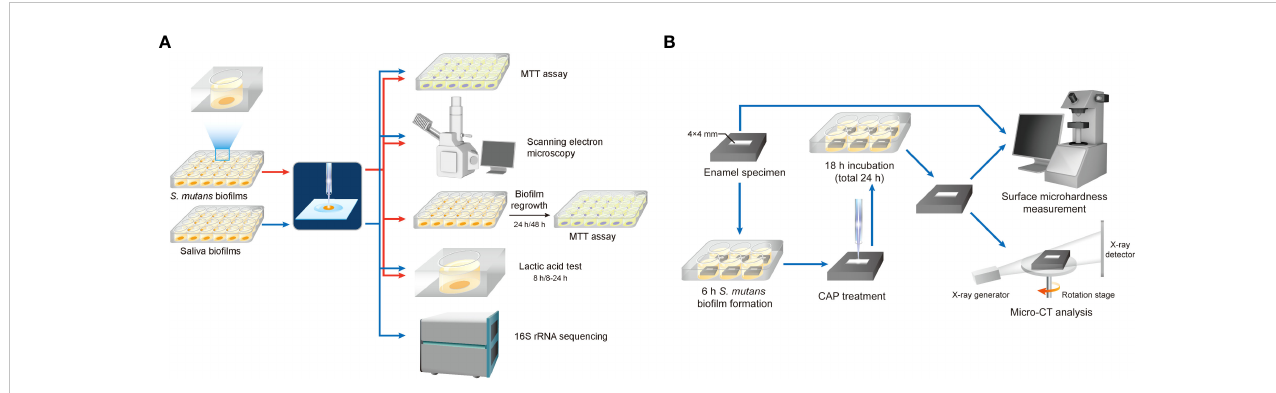
FIGURE 2 Work fl ow diagram. (A) Effects of CAP on the proliferation of oral microorganisms. (B) Effects of CAP on demineralization of tooth